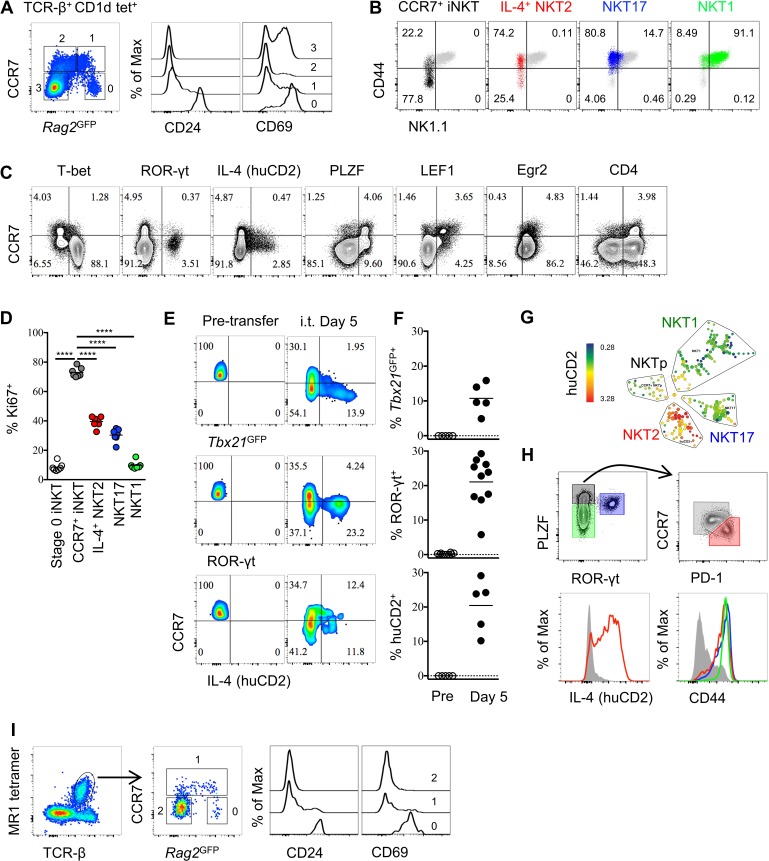
Thymic CCR7+ iNKT and MAIT cells are at an early developmental stage and give rise to distinct effector subsets in the thymus.(A) Expression of Rag2GFP and CCR7 in thymic iNKT cells (TCR-β+ CD1d-PBS57+) (left column), and of CD24 (middle column) and CD69 (right column) on cells with different levels of Rag2GFP. Data are representative of 3 independent experiments with 3–4 mice in each. (B) Expression of NK1.1 and CD44 in thymic CCR7+ iNKT (black dots), IL-4+ (human CD2+) NKT2 (red dots), ROR-γt+ NKT17 (blue dots), T-bet+ NKT1 (green dots) cells together with total thymic iNKT cells (grey dots). Numbers in quadrants indicate percent cells in each for CCR7+ iNKT (black dots), IL-4+ (human CD2+) NKT2 (red dots), ROR-γt+ NKT17 (blue dots) and T-bet+ NKT1 (green dots) cells. Data are representative of 4 independent experiments with 2–3 mice in each. (C) Expression of T-bet, ROR-γt, huCD2, PLZF, LEF1, Egr2 and CD4 with CCR7 in thymic iNKT cells (TCR-β+ CD1d-PBS57+ CD24–). Data are representative of 3 independent experiments with 2–3 mice in each. Numbers in quadrants indicate percent cells in each (throughout). (D) Frequency of Ki67+ cells in each population of thymic iNKT cells. Data are pooled from three independent experiments with 2–3 mice in each. ****p<0.0001 (one-way ANOVA, Tukey’s multiple comparisons test) Each symbol represents an individual mouse; small horizontal lines indicate the mean. (E) Expression of Tbx21GFP, ROR-γt and human CD2 in CCR7+ iNKT cells sorted from BALB/c Tbx21GFP KN2 mice before intra-thymic transfer (left column) or 5 days after transfer in the thymus of congenic BALB/c recipient mice (right column). (F) Frequency of Tbx21GFP+, ROR-γt+ or human CD2+ cells in donor cells before or 5 days after intra-thymic transfer into the thymus of congenic BALB/c recipient mice. Each symbol represents an individual recipient mouse; small horizontal lines indicate the mean. (G) SPADE analysis of thymic iNKT cells from B6 KN2 mice supports that CCR7+ NKTp are a distinct lineage from the effector subsets, NKT1, NKT2 and NKT17. Representative figure shows differential expression of human CD2 in each population of iNKT cells. (H) CCR7 and PD-1 distinguish two cell populations (top row, right column) within PLZFhi iNKT cells (top row, left column), and expression of human CD2 and CD44 in CCR7+ NKTp (grey), NKT1 (green), NKT2 (red) and NKT17 (blue) are shown as overlays (bottom row). Data are representative of 3 independent experiments with 3 mice in each. (I) Expression of Rag2GFP together with CCR7 (middle column) in thymic MAIT cells (far left column), and expression of CD24 and CD69 in CCR7+ and CCR7– MAIT cells with different level of Rag2GFP (far right two columns). Data are representative of 2 independent experiments with 3 mice in each.10.7554/eLife.34793.006Figure 1—source data 1.High proliferative and precursor potential of CCR7+ iNKT cells.10.7554/eLife.34793.007Figure 1—source data 2.Thymic CCR7+ iNKT cells are distinguished from stage 0 iNKT cells and give rise to iNKT subsets in periphery.10.7554/eLife.34793.008Figure 1—source data 3.Consistent, robust and unbiased labeling of thymocytes by intra-thymic injection of biotin.